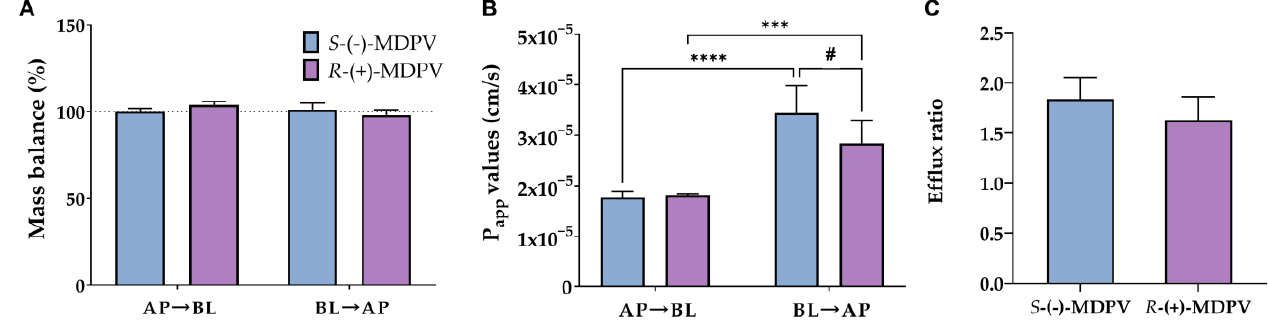
Figure 8. Mass balance ( A ), P app values ( B ), and efflux ratios ( C ) obtained for the enantiomers of MDPV ( S -(-)-MDPV and R -(+)-MDPV) after the permeability assay with Caco-2 cells. Results are expressed as mean ± SD obtained from three independent experiments (performed in duplicate). # p < 0.05 (between enantiomers), *** p < 0.001, **** p < 0.0001 (between directions).